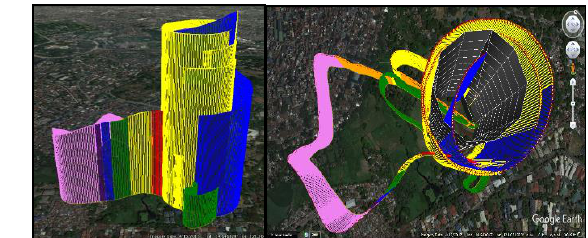
Figure 11. The planned path (cylindrical)